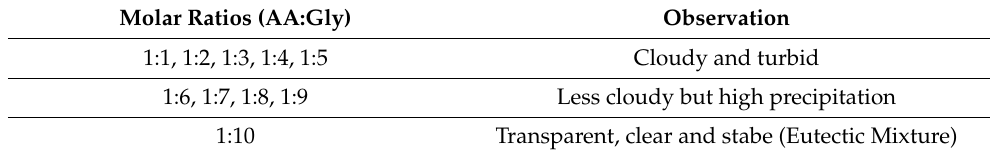
Table 4. Preparation of AA:Gly NADES.